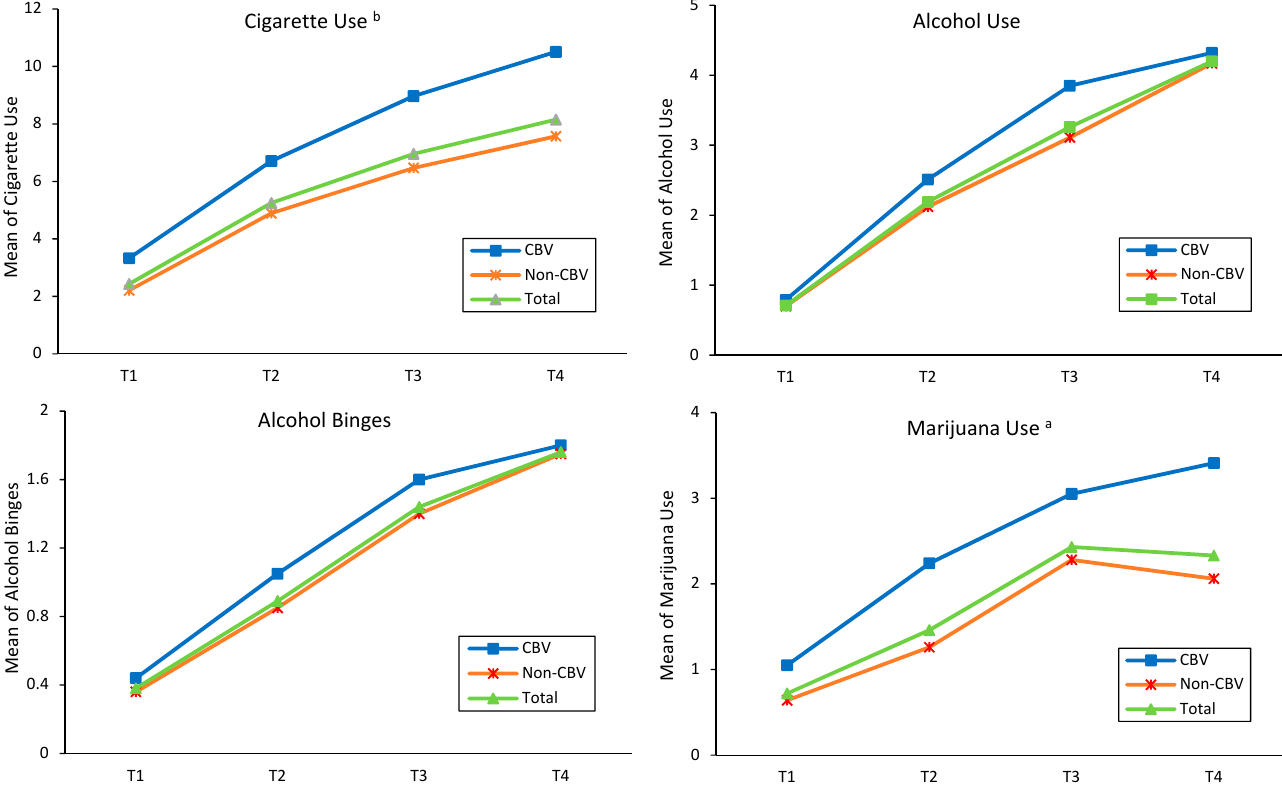
Figure 1. Trend in rates of substance use by CBV from Time 1 to Time 4. a p < 0.05, b p < 0.01.